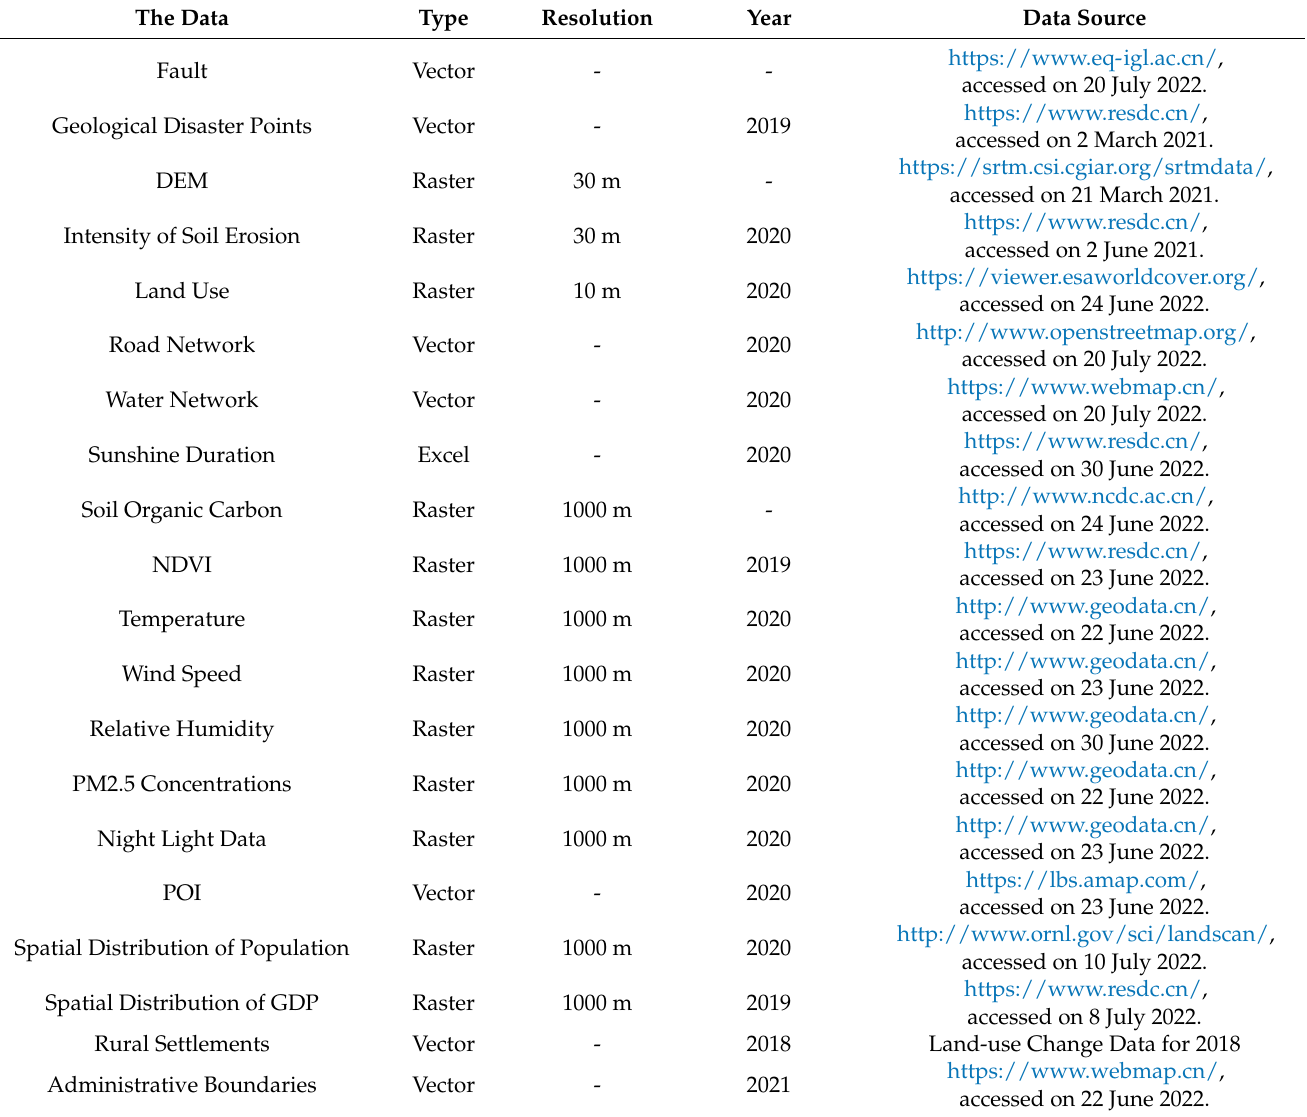
Table 1. Data Sources and